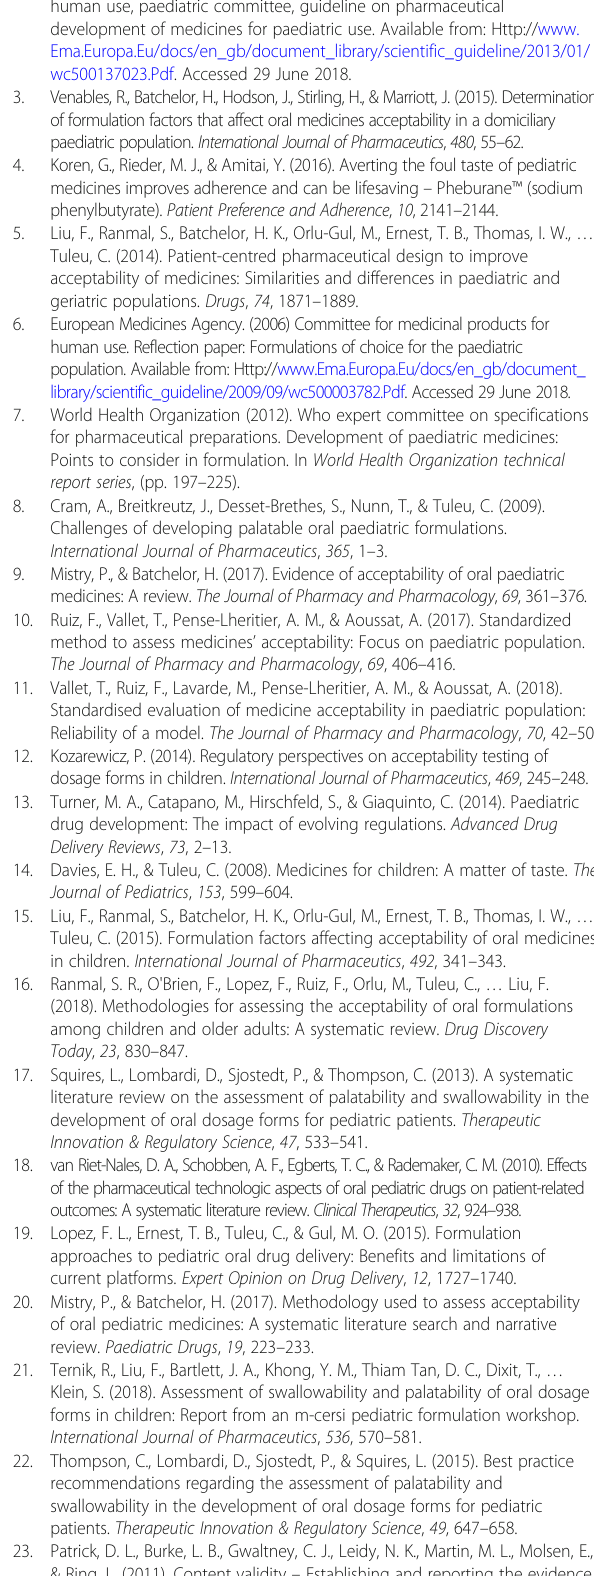
Additional file 7: Table S4. Frequency of each acceptability attribute reported by pediatric participants during the concept elicitation